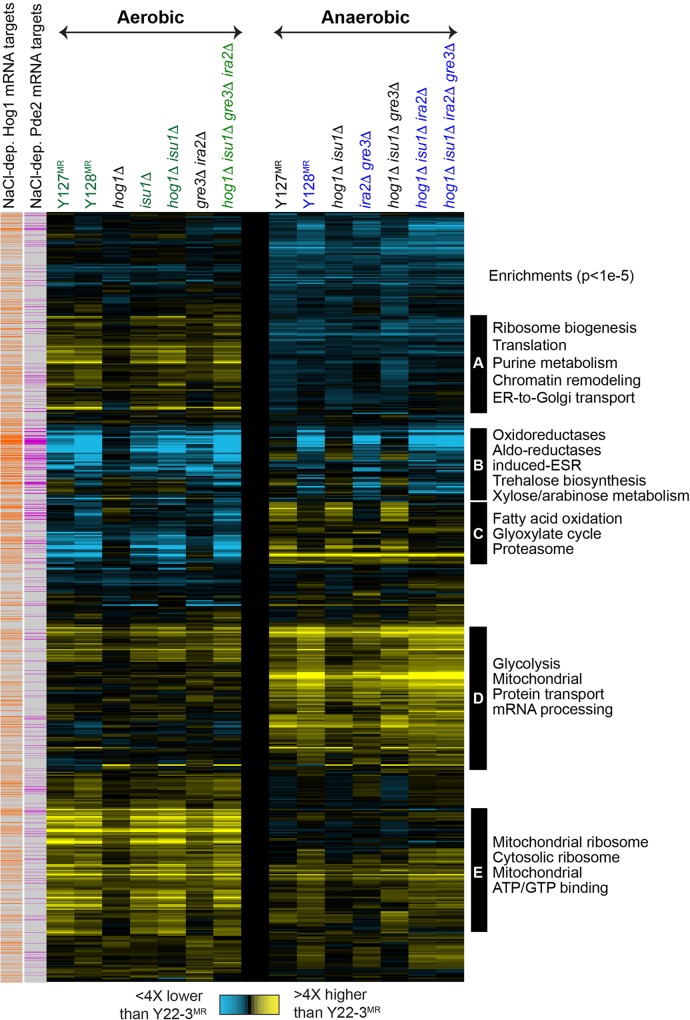
Proteomic changes across strains implicate physiological responses.The heat map shows the average relative protein abundance for 3,660 proteins (rows) in each denoted strain (columns) compared to Y22-3MR grown aerobically (left) or anaerobically (right) on xylose as the sole carbon source. Genotypes indicated in green or blue denote strains that can grow on xylose aerobically or contain mutations in IRA2, respectively. Yellow indicates higher abundance and blue indicates lower abundance according to the key. Data were pooled and organized by hierarchical clustering [95]. Functional groups enriched in denoted clusters at p < 1e-5 (hypergeometric test [94]) are annotated to the right of each cluster. Proteins encoded by mRNAs whose salt-dependent expression is dependent on Hog1 or the phosphodiesterase Pde2 (which indirectly represses PKA activity through cAMP degradation, [21]) as defined in [48] are shown as orange or magenta boxes, respectively.